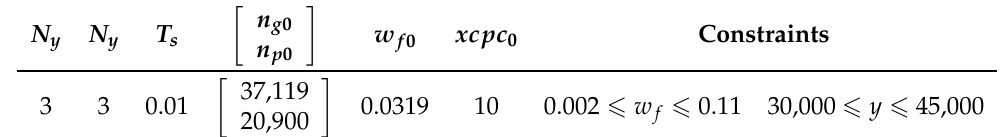
Table 2. Simulation parameter